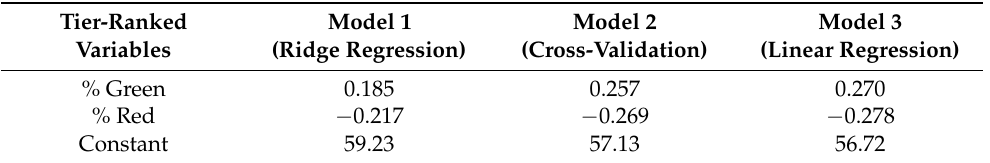
Figure 1. Percentage of green, yellow, and red foods by quintiles of HEI scores ( n = 503). The statistical learning results from the Models 1, 2, and 3 are reported in Table 1. Table 1. Coefficients from the statistical learning methods using Ridge regression (Model 1), cross- validation (Model 2), and linear regression (Model 3), using percentage of green foods and percentage of red foods as predictors and HEI score as the outcome ( n = 503).